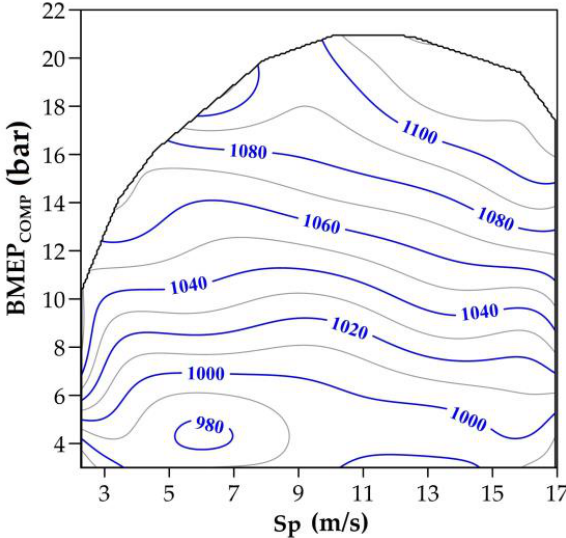
Figure 12. Exhaust gas temperature (K) related to the optimal exhaust pressure levels of the compound engine, as a function of load and mean piston speed.